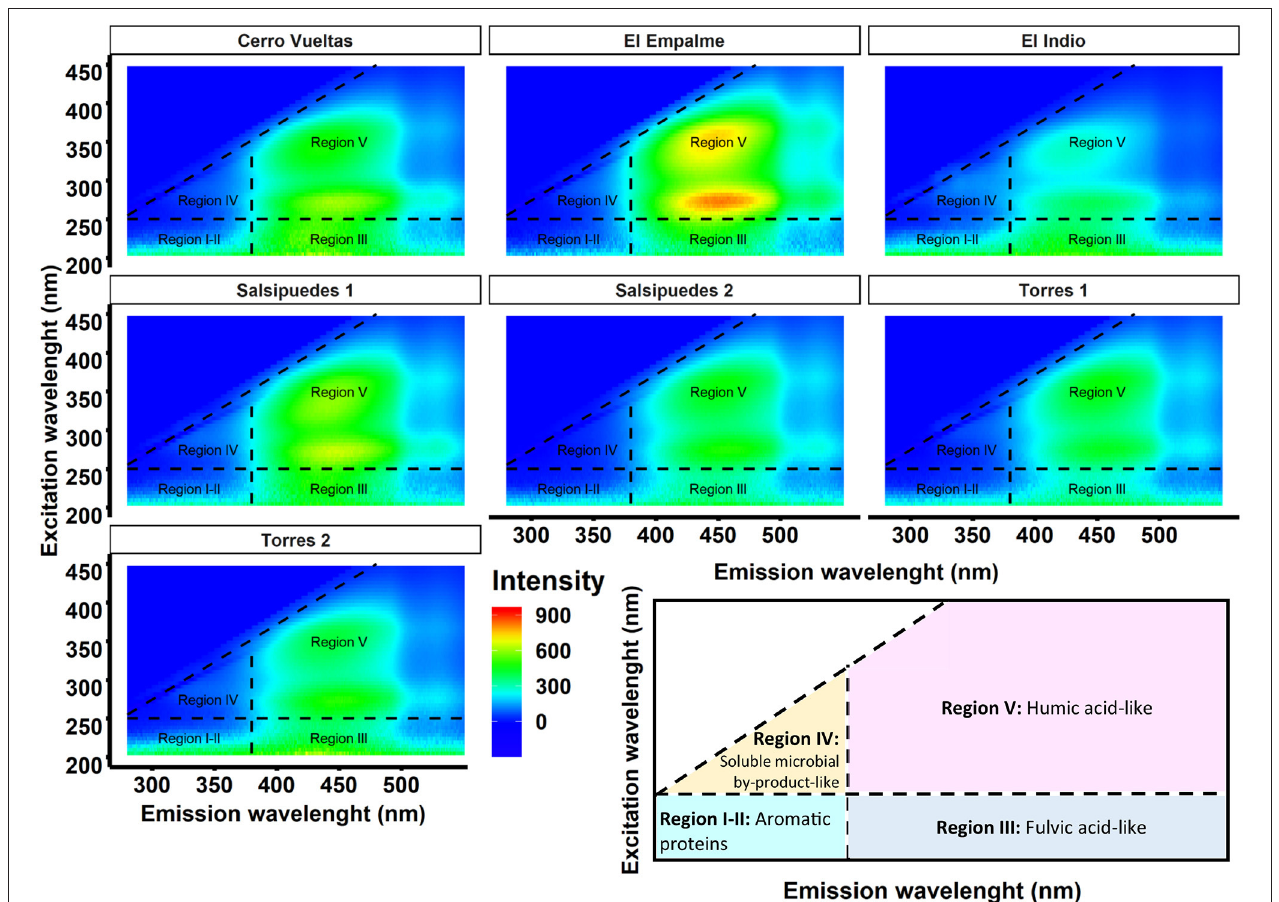
FIGURE 7 | Aggregated fluorescence excitation/emission matrices (EEMs) per sampling site. The inset shows five EEM regions defined by wavelength boundaries ( Chen et al., 2003 and references therein) in absolute fluorescence intensity. El Empalme and El Indio represent the lowest and highest sampling sites, respectively (see Figure 1